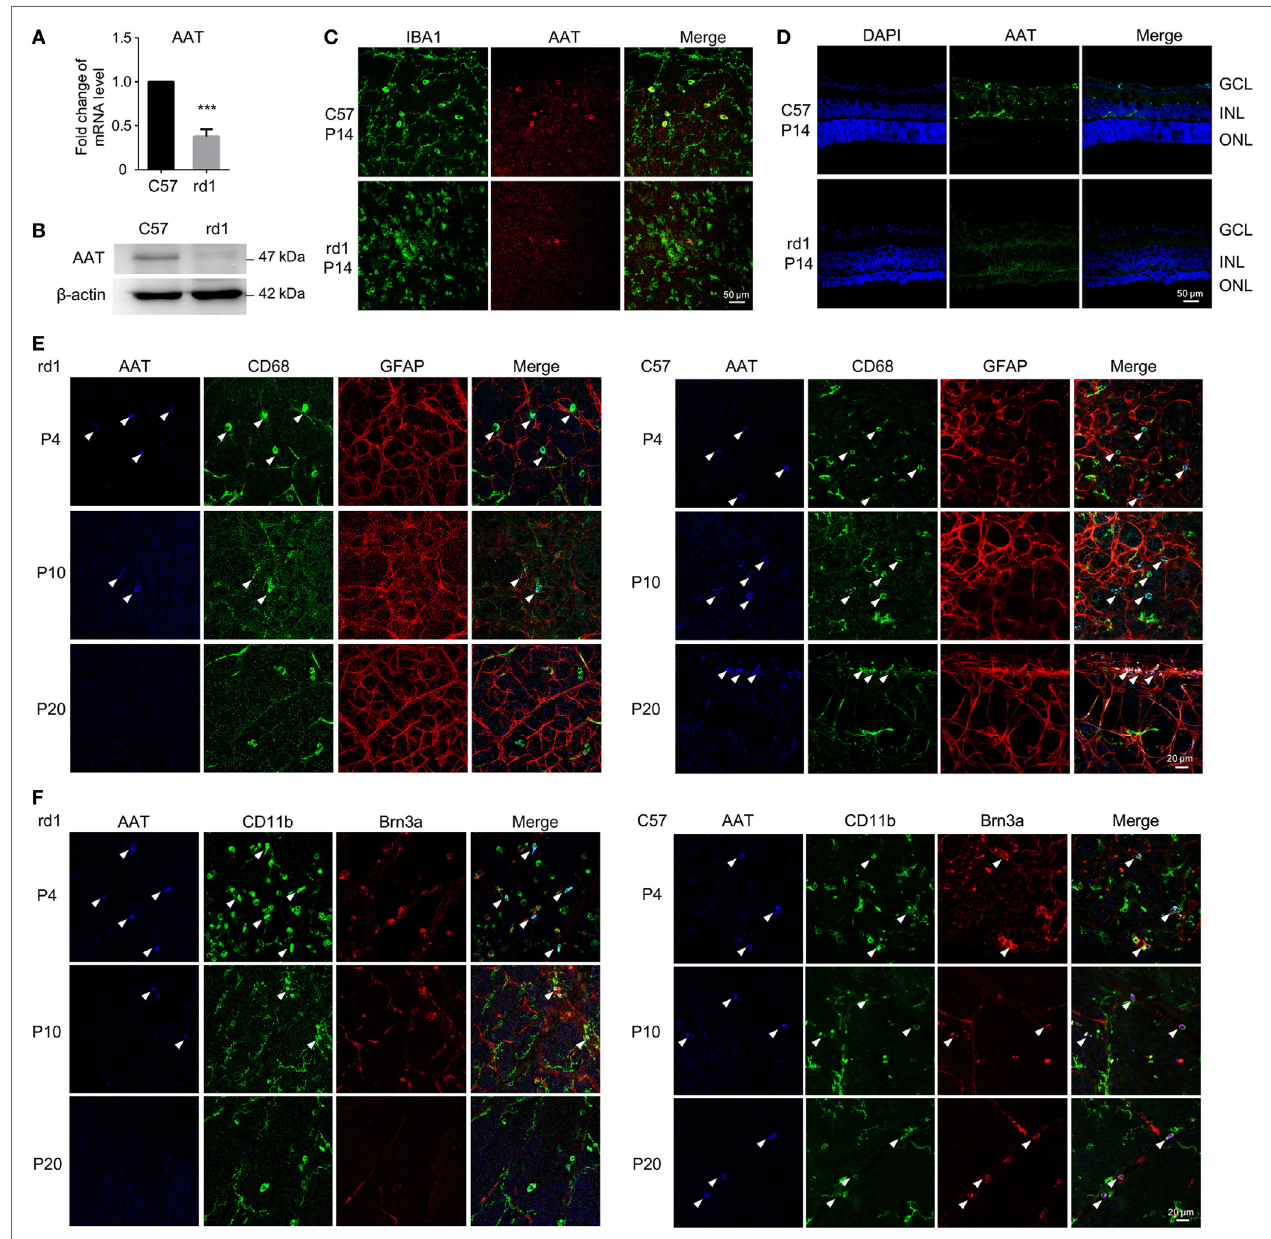
FigUre 1 | Alpha-1 antitrypsin (AAT) expression decreased in rd1 mice. (a,B) Real time PCR (a) and western blot (B) results revealed that the expression of AAT decreased in retina from rd1 mice compared with C57 controls at P14. *** p < 0.001 (two-tailed unpaired t -test). (c) . There were some cells co-staining with AAT (red) and IBA1 (green) in C57-retina, whereas lack of AAT was observed in the retina from rd1 mice at P14. (D) Immunofluorescence on retinal section showed that AAT was mainly distributed in the inner nuclear layer in C57 mice, while the rd1 mice lacked AAT expression. (e,F) In retinal whole mounts, expression of AAT was decreased as the disease progressed from P4 to P20 in rd1 mice, whereas C57 mice presented stable expression of AAT during the same time. Of note, AAT was co-labeled mostly with CD68 (e) and CD11b (F) , also markers for microglia in the retina, slightly with Brn3a + retinal ganglion cell (F) , but not with GFAP + astrocytes/ Müller cells (e) . Scare bar, 50